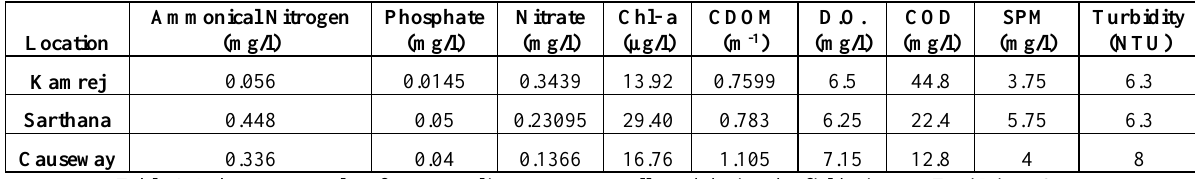
Table 2: Laboratory results of water quality parameters collected during the field trip over Tapi River, Surat Although during monsoon, lot of agriculture run-off and nutrients will come into the river, but main flow of water will dilute its concentration. During summer, the same nutrient